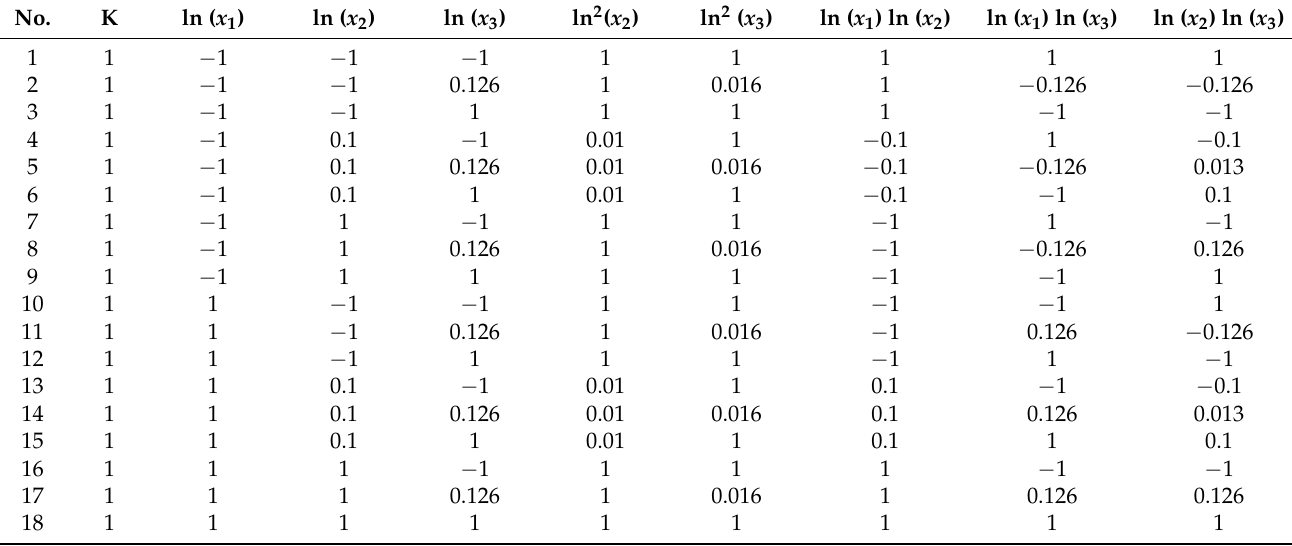
Table 5. Experiment plan (matrix G